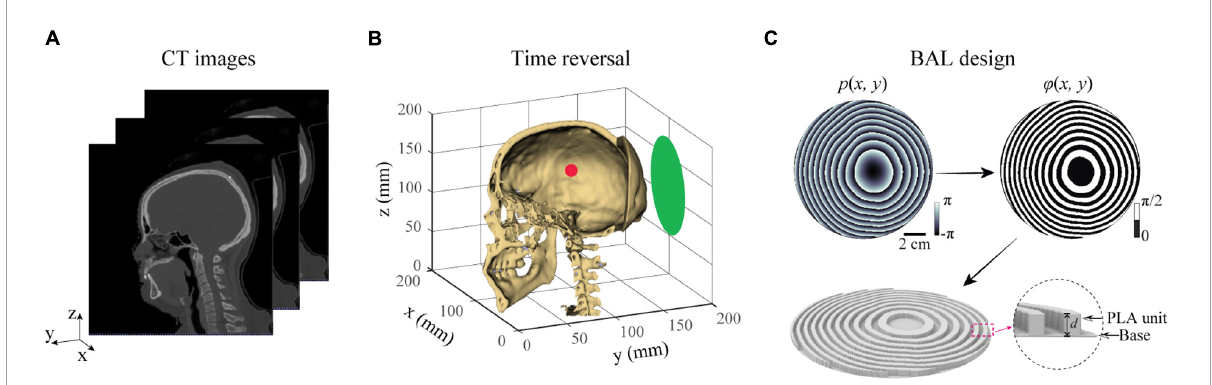
FIGURE1 Methods for designing a BAM for transcranial focused ultrasound. (A) CT-scan of a human head was used to perform numerical simulations of the ultrasound wave propagation in the brain. (B) A virtual acoustic source (red dot) was placed at the targeted brain location. Time reversal was then used to calculate the phase profile on the surface of the lens (green plane). (C) A BAM was designed by binarizing the calculated phase profile from (B) , and rendered into a 3D-printed model with two coding bits, a polylactic acid (PLA) unit for bit “1” and a water unit for bit